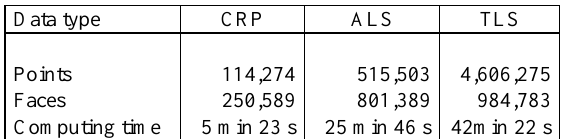
Table 1. Selected parameters of the input data derived from